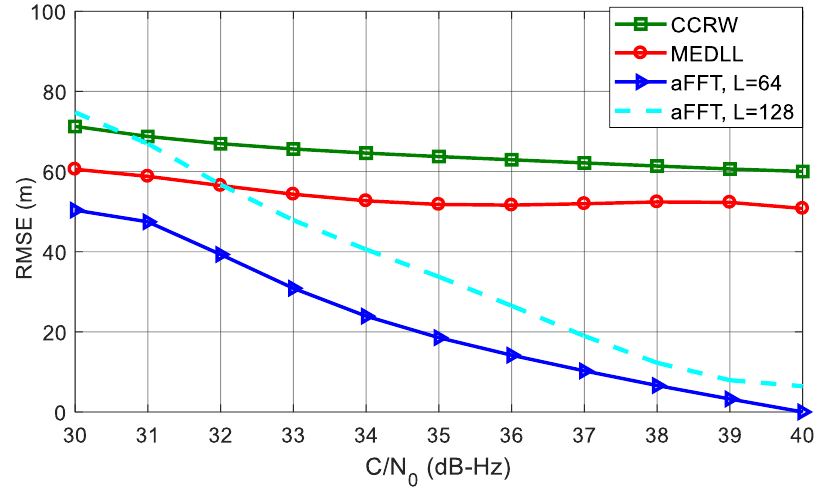
Figure 13. RMSE curves of averaging-FFT, MEDLL and CCRW methods in the presence of three paths.